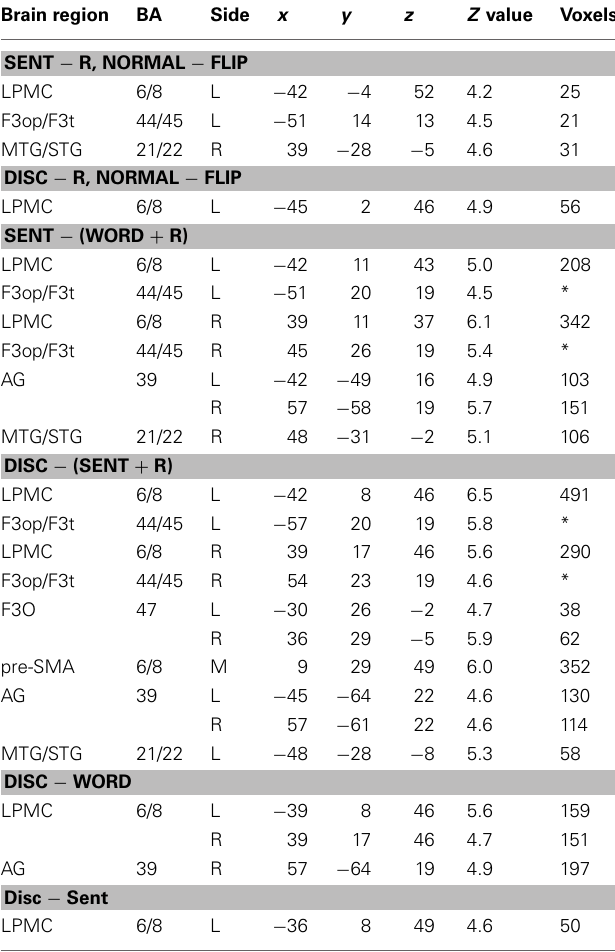
Table 5 | Lateralization and functional localization of cortical